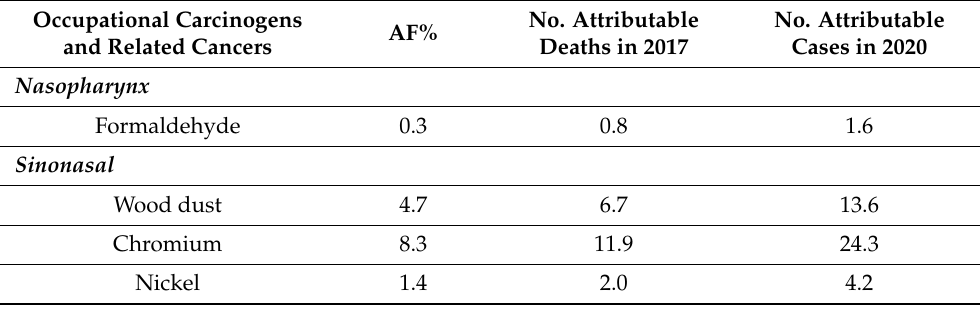
Table 4. Population attributable fractions (AF) by cancer type and occupational carcinogen in Italy. N =